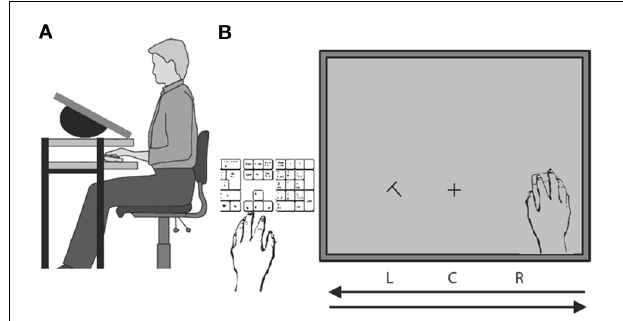
FIGURE 1 | Schematic illustration of the experimental setup. (A) Side view. (B) Bird’s eye view of the two hands and their respective tasks. The right hand was always moving from right to left and back on a shelf under the display. Participants discriminated a probe letter (T or L) that was briefly displayed to the left or right of a fixation cross and was followed by an F-shape mask (not illustrated). Probes were displayed when the right hand reached positions R, C, or L during either leftward or rightwards movement. After motion completion the participant indicated the probe’s identity by keyboard press with the visible left hand.